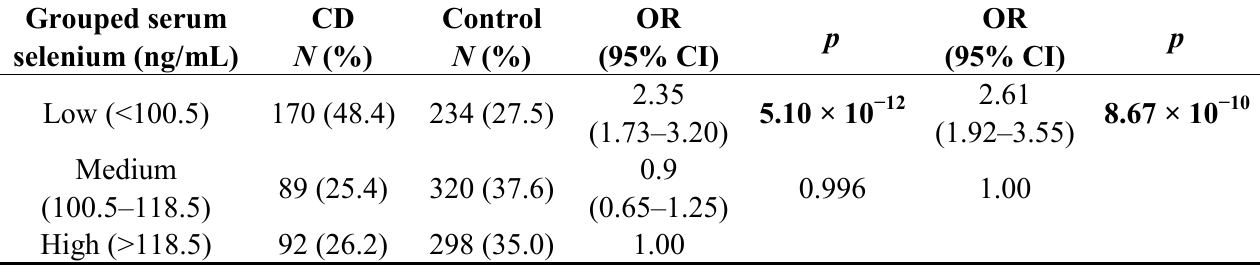
Table 2. Odds ratio of Crohn’s Disease (CD) status with grouped serum selenium levels. Grouped